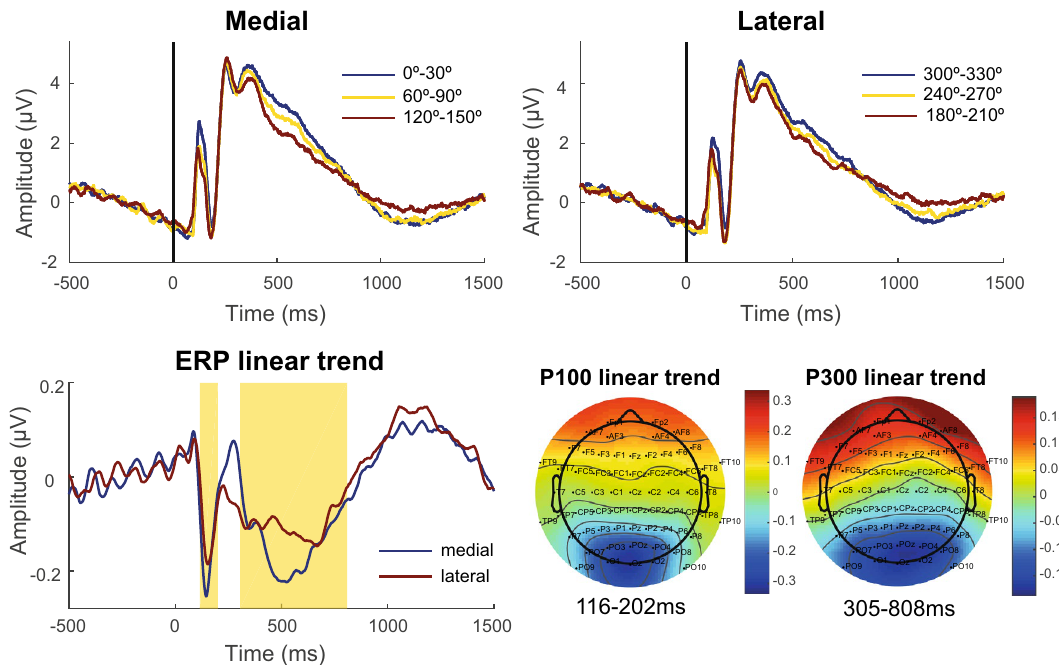
Figure 4. Defining window for ERP analysis. ( A ) Grand-average ERPs by double angles and orientations. ( B ) ERP linear trend. ( C ) Topography of the linear trend for each time interval defined for ERP analysis. The blue color represents the regions in which the ERP’s negativity increases due to the stimulus